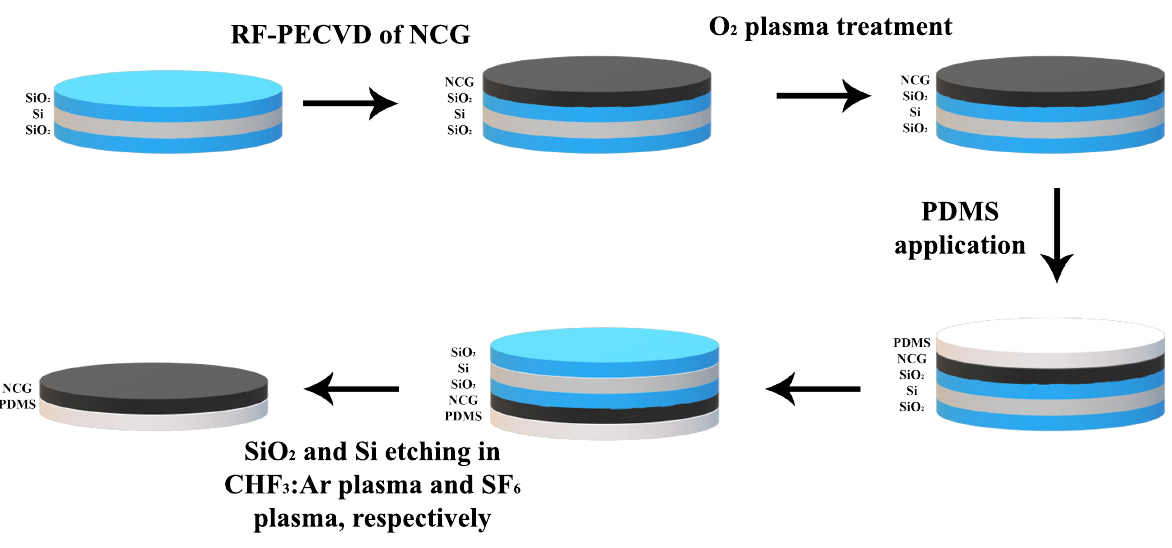
Figure 1: Schematic representation of the technological